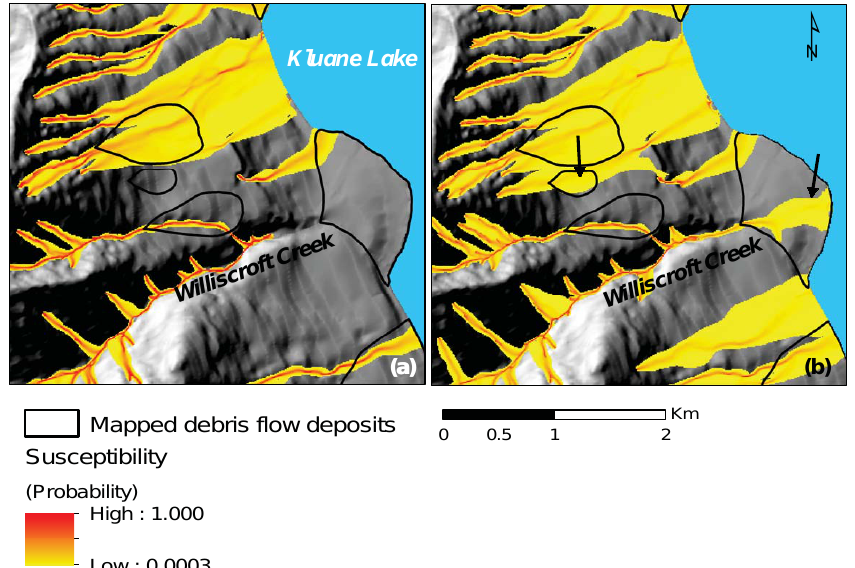
Figure 4. a) The propagation of source areas in and around Williscroft Creek area (box A in Fig. 1): (a) based on the threshold value of − 1.5 / 100m − 1 , and (b) based on the threshold value of − 1/100m − 1 . Note the two debris flow deposits that are captured only in (b) are shown with black